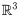
Critical manifold C0 and singular periodic orbit so.The figure shows the critical manifold (4) associated with the cardiac AP model (1) for two different values of the model parameter GK. C0 is a folded surface in R3 with attracting Sa+, Sa- and repelling sheets Sr separated by two fold lines F+ and F−. The projections of F+ and F− onto Sa- and Sa+ are denoted by P(F+) and P(F−). Also shown is the singular orbit so that consists of slow segments on Sa+, Sa- and fast jumps between them. Inside the funnel region, which is bounded by the singular strong canard γs and F+, all trajectories approach the folded node FN allong the eigendirection e2 associated with the singular weak canard γw. SF denotes a saddle-focus equilibrium of the full system (1). A: GK = 0.04. The singular orbit is projected into the funnel, which is a key reason for the appearance of EADs in the solution of the full system (1). B: GK = 0.06. the singular orbit so lands outside of the funnel. Consequently, EADs do not appear in the solution of the full system (1).